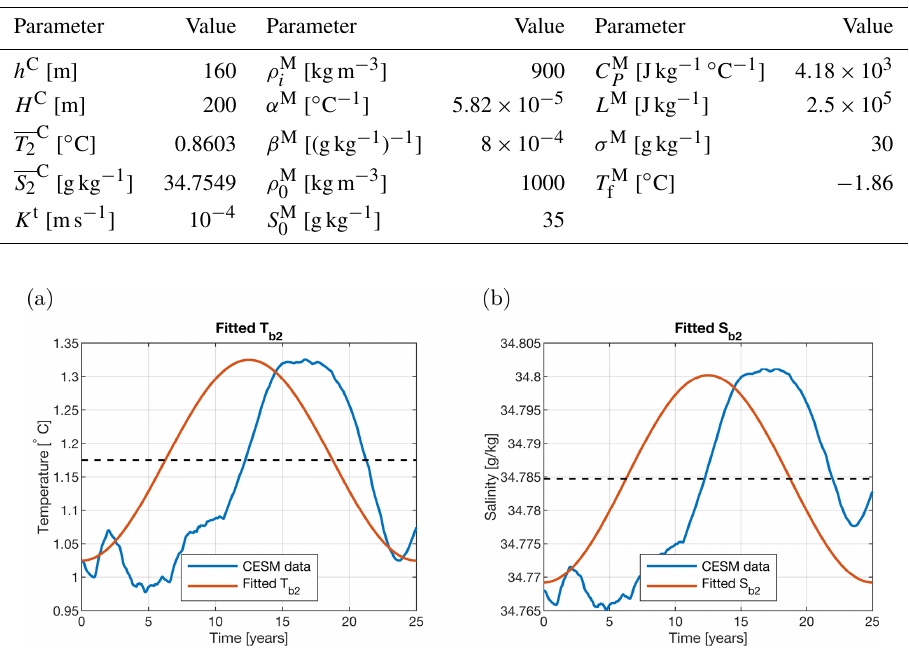
Table 2. Standard parameter values used in the model. Superscripts show whether the parameter value is determined from the CESM simulation of van Westen and Dijkstra (2020a) (C), determined through tuning (t), or taken from Martinson et al. (1981) (M). Overbars represent mean values (averaged over a 25-year cycle).